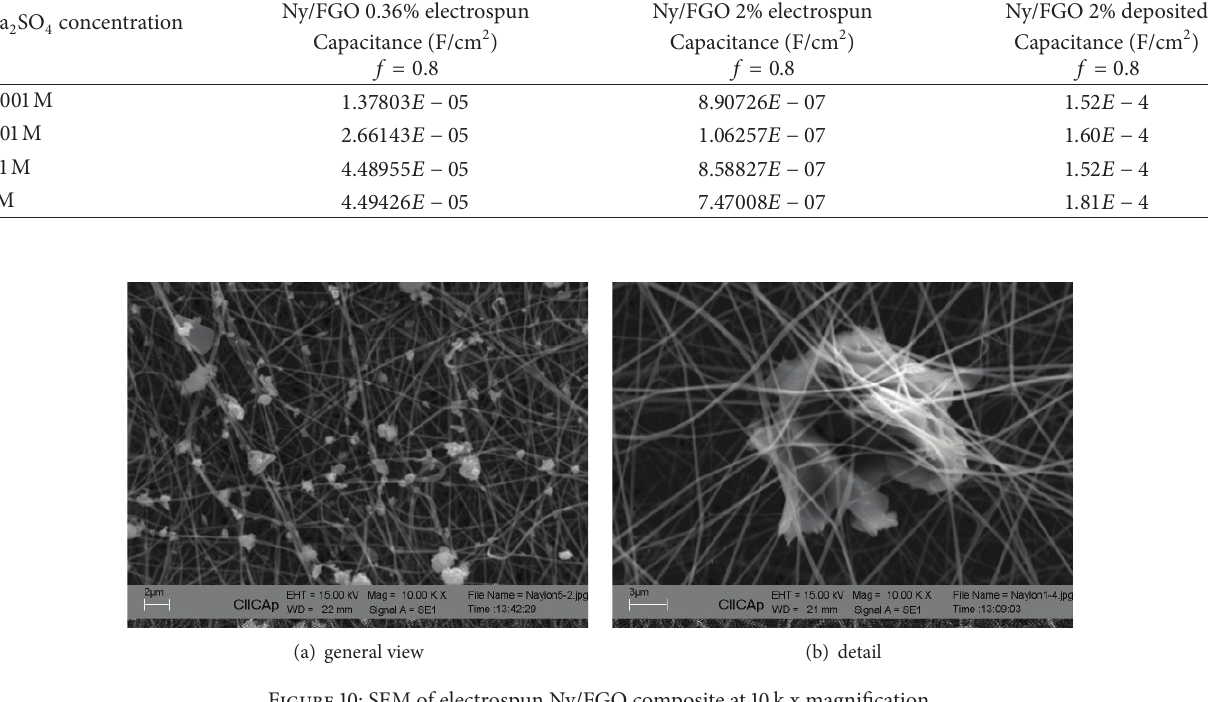
Table 1: Determined capacitance at low and high frequency of the Ny/FGO systems using different Na